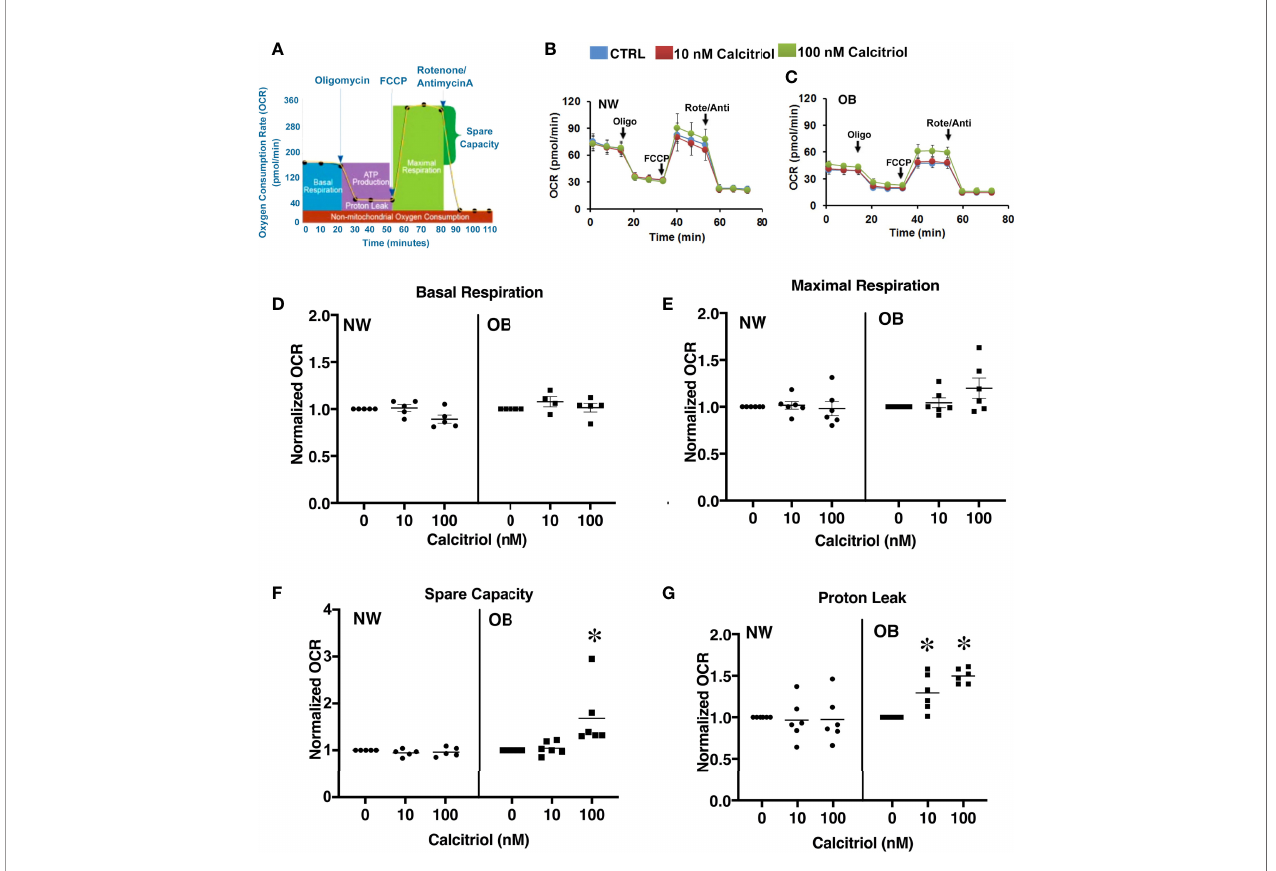
FIGURE 4 | Dose-dependent effect of 24-hour treatment with calcitriol on mitochondrial function in cytotrophoblasts isolated from placentae of NW and OB women. Data from males and females were combined. (A) Flowchart of the Seahorse XF Cell Mito Stress test; (B, C) Representative curves. (D) Basal respiration. (E) Maximal respiration. (F) Spare capacity. (G) Proton leak. *, p < 0.05,